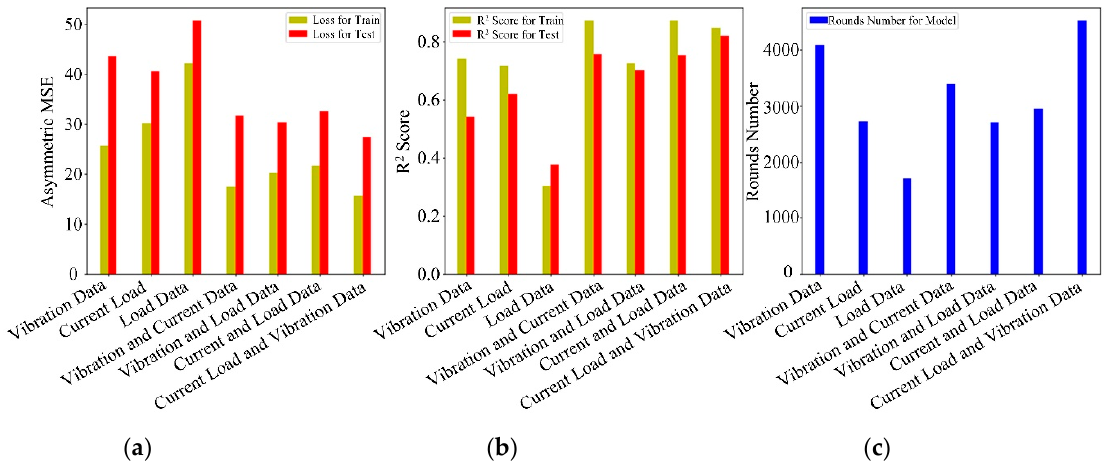
Figure 7. Comparison chart of different evaluations. ( a ) Asymmetric Loss. ( b ) R 2 Score. ( c ) Boosting Rounds.